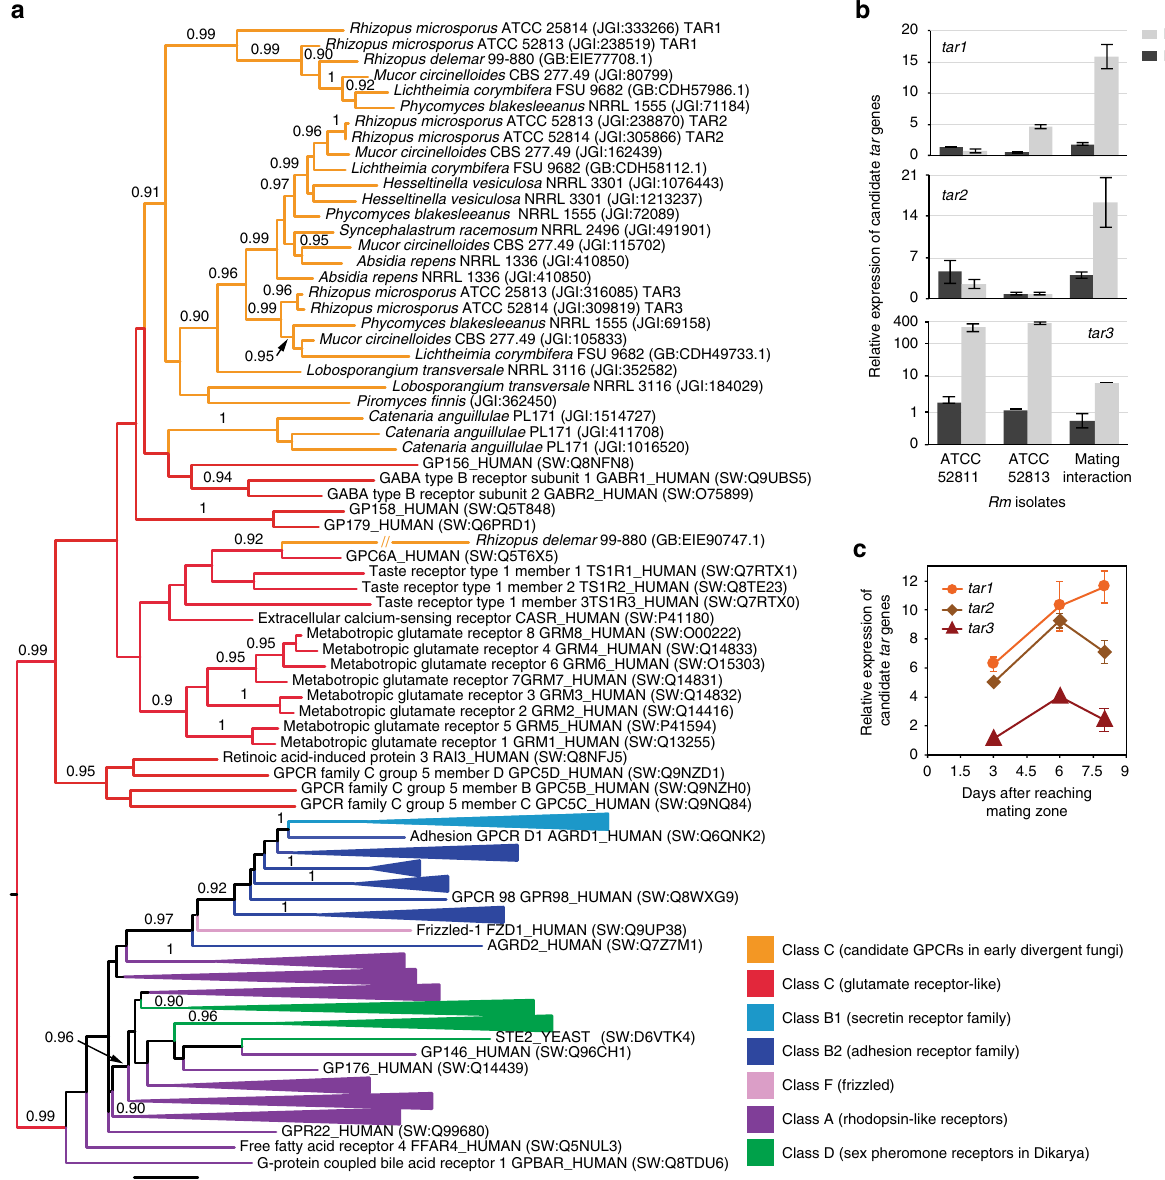
Fig. 3 Candidate trisporic acid receptors are class C GPCRs. a Maximum-likelihood phylogeny of seven - transmembrane domains from early-diverging fungi (orange) and fi ve different classes of G-protein-coupled receptors (GPCRs): A (purple), B1 (light blue), B2 (dark blue), F (pink), as well as the fungal - speci fi c class D pheromone receptors (green). Fungal protein identi fi ers include species and strain designation, as well as GenBank accession number or JGI protein ID. Nonfungal proteins have GPCRdb 74 identi fi ers and UniProtKB 75 (SW) accession numbers. Support values are displayed above branches. The GPCR sequence alignment and the complete phylogeny are included in Supplementary Data 3 and Supplementary Data 4, respectively. TAR, candidate trisporic acid receptor. b Expression levels of the candidate tar genes in Rm . Three biological replicates were examined per condition. B(+), endobacteria present; B( − ), endobacteria absent; error bars represent s.e.m. c Changes of the candidate tar gene expression patterns during the progression of mating in Rm B(+) mates measured in three replicate cultures per time point. Error bars represent